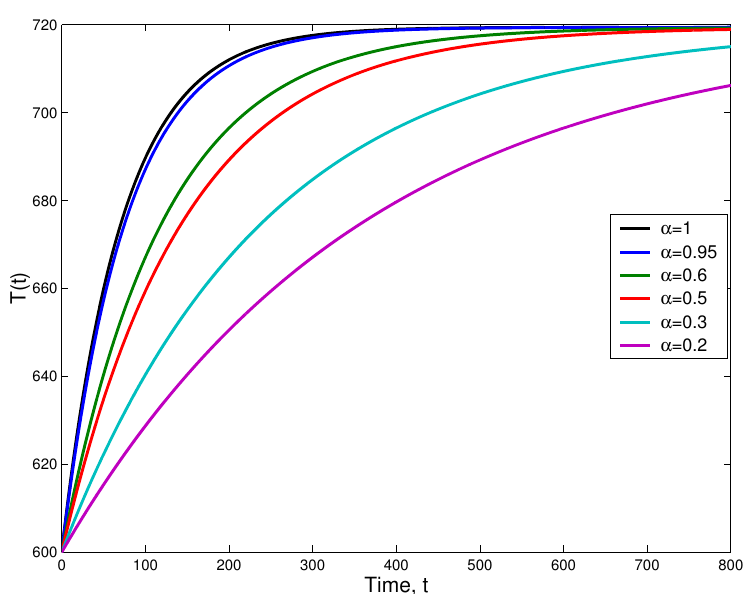
Figure 1. Graph of (20) for different values of α and β =